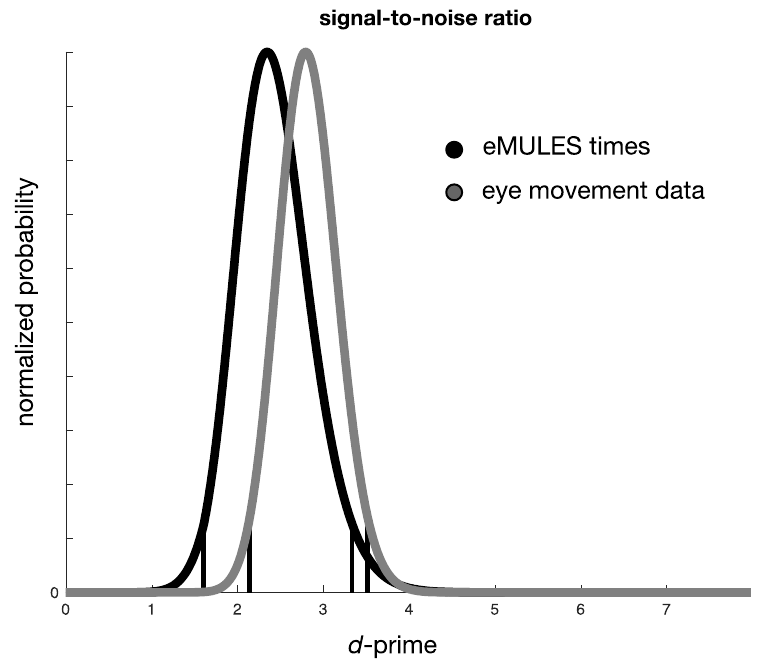
Figure 5. Posterior distributions over the d-prime (discrimination) measure based either on MULES times or eye movement data. The two curves represent d-prime computed based on either MULES times or eye movement data, where d-prime indicates the signal-to-noise ratio of discriminating concussion from control data.